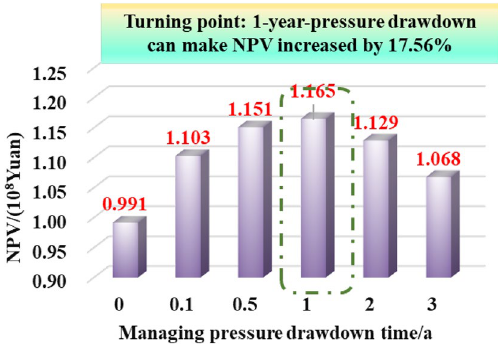
Figure 36. 20-year NPV chart for different pressure control duration.